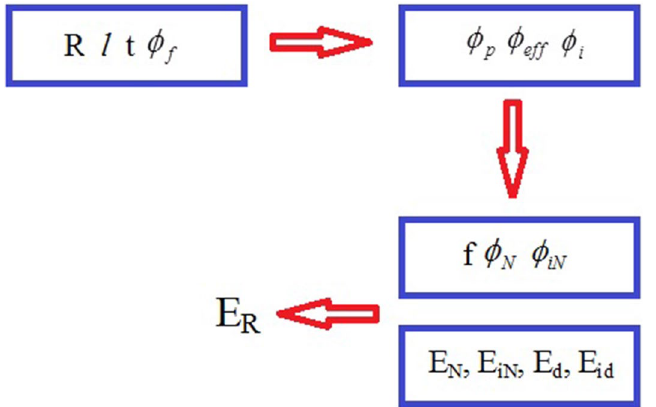
Figure 1. Schematic of the process of predicting the relative modulus by using Eq. (13) and various parameters and equations.